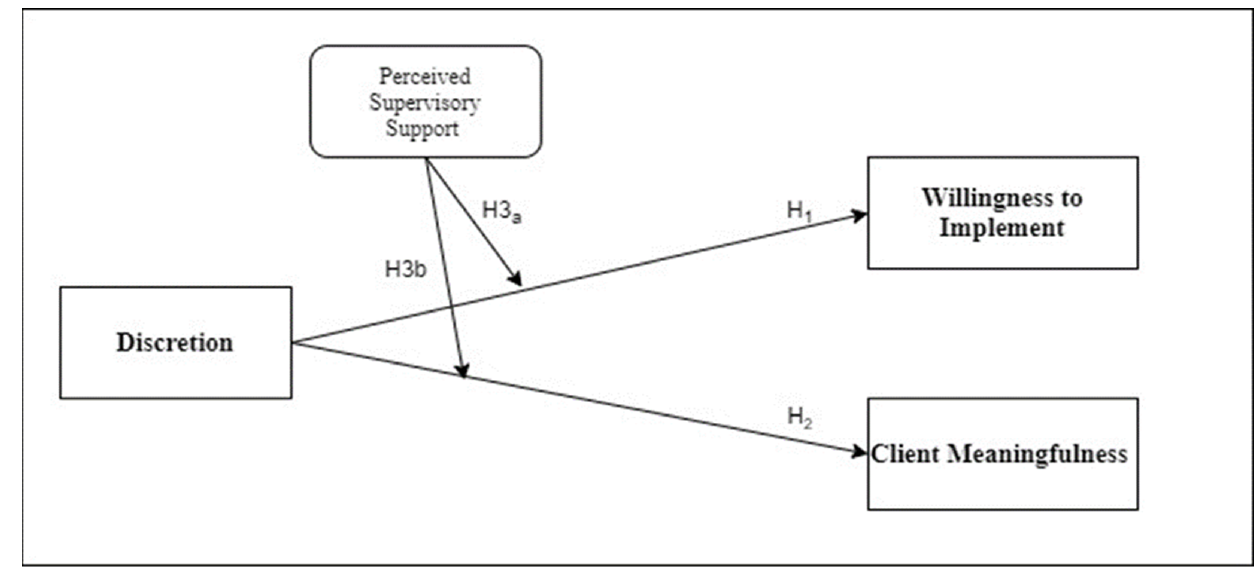
Figure 1. Research framework.